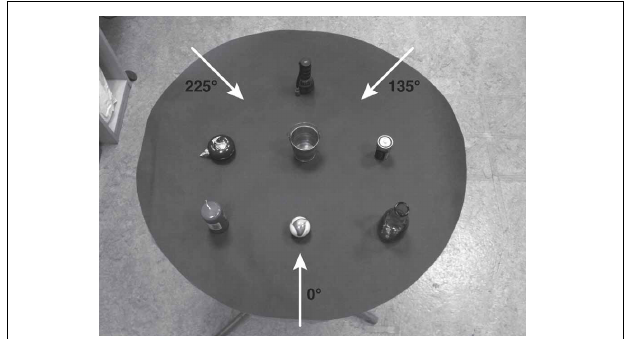
FIGURE 3 | The seven-object layout used in Galati and Avraamides (in revision), whose configuration had an intrinsic structure. It comprised a flashlight, a yoyo, a bucket, a battery, a candle, a marble, and a vase. The arrows at 0 ◦ , 135 ◦ , and 225 ◦ represent the viewpoint that Directors and Matchers occupied at the different conditions of their relative alignment with the intrinsic